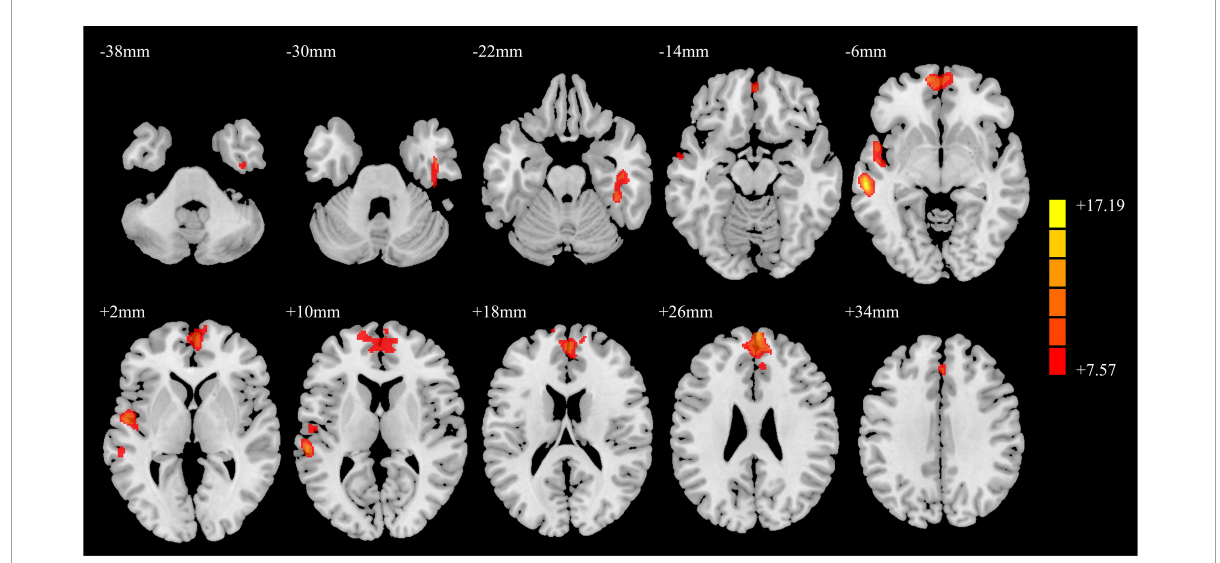
FIGURE1 ANCOVA results of gray matter volumes in the PD-MH, PD-NH, and HC groups. Red and yellow indicated altered gray matter volume. Using GRF correction, voxel level P < 0.001 and cluster level P < 0.05 were considered statistically significant difference. ANCOVA: analysis of covariance; PD, Parkinson’s disease; MH, minor hallucination; NH, no hallucinations (and delusions); HC, healthy control; GRF, Gaussian random field.